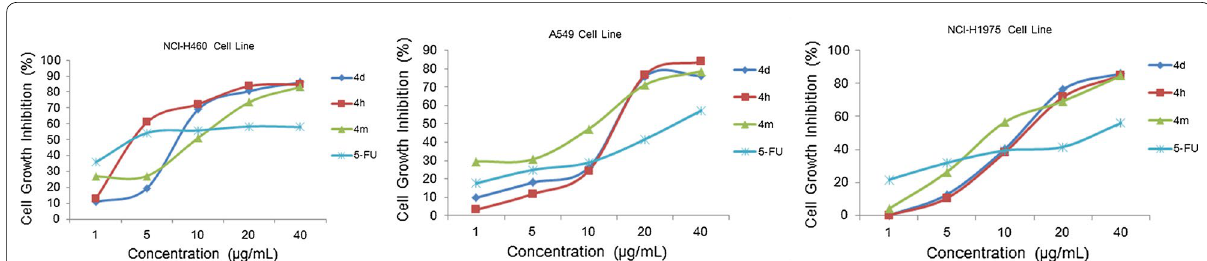
Fig. 5 Dose-response analysis of cell growth inhibition activity for representative compounds 4d , 4h , 4m and 5-FU (positive control) against NCI- H460 (left), A549 (middle) and NCI-H1975 (right) cell